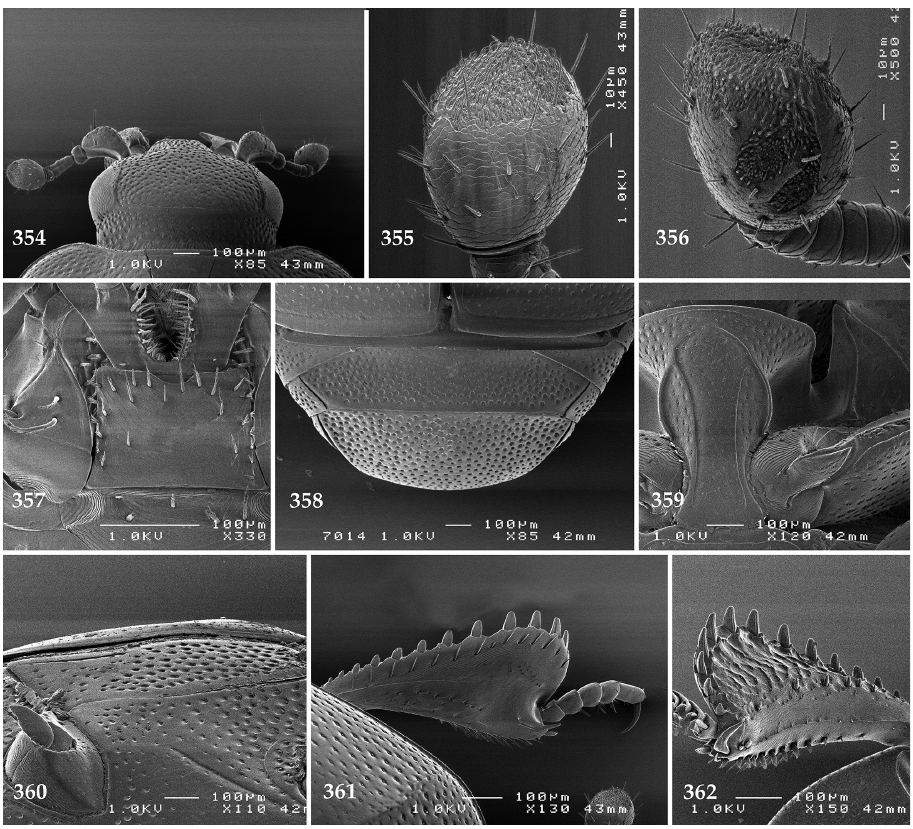
Figures 354–362. 354 Saprinus ( Saprinus ) chalcites (Illiger, 1807) head, dorsal view 355 antennal club, dorsal view 356 ditto, ventral view 357 mentum, ventral view 358 propygidium + pygidium 359 prosternum 360 lateral disc of metaventrite + metepisternum 361 protibia, dorsal view 362 ditto, ventral